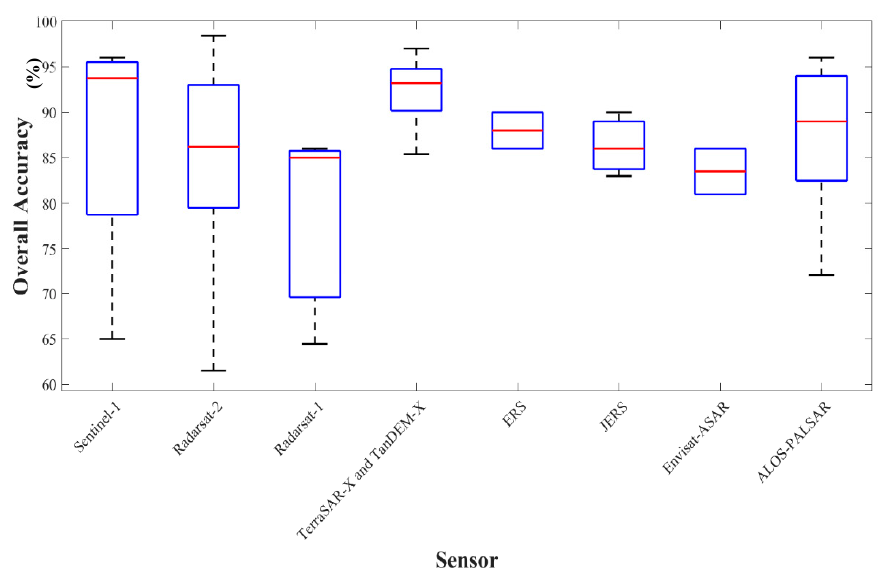
Figure 14. Box-and-whisker plots illustrating the overall accuracy of classification result attained based on the SAR sensors applied. Articles that used multiple SAR sensors are excluded from this analysis. Figure 15 highlights the e ff ect of the SAR configuration on wetland classification accuracy.